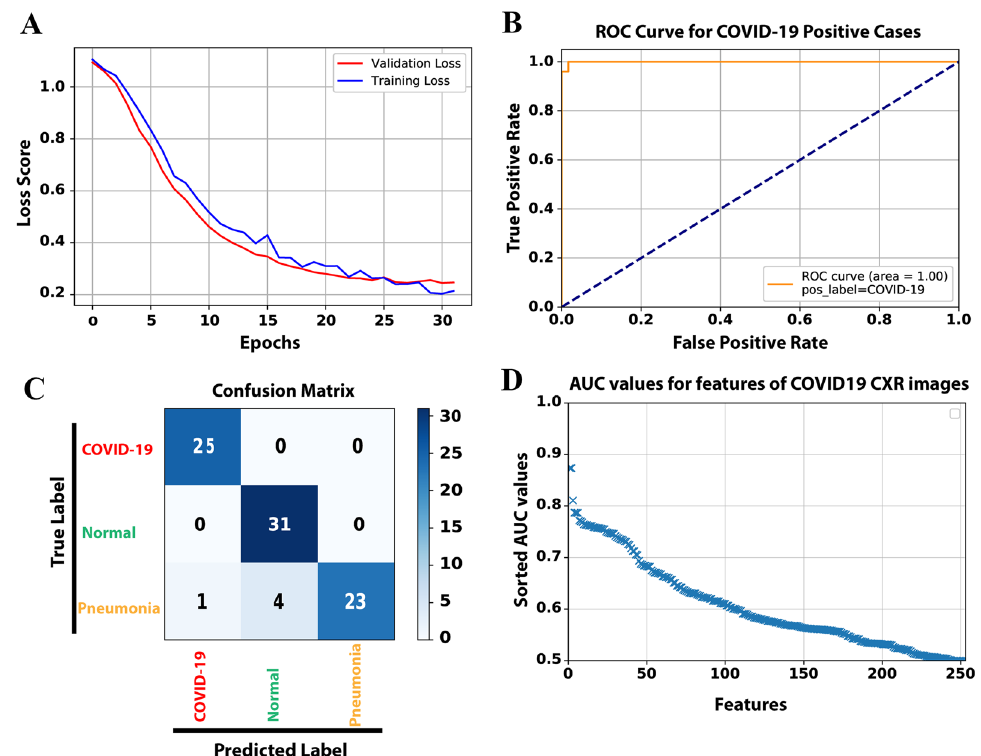
Figure 3. (A) The loss score graph of the training and validation sets during the model training process. (B) The ROC curve, generated from 84 test samples, while COVID-19 is assigned as the positive class. (C) The Confusion matrix of predicting 84 test samples in three categories. (D) To compare and analyze the discrimination power of different single features among the original 252 extracted features, we used AUC values as an indicator. All features were sorted in the order of their AUC